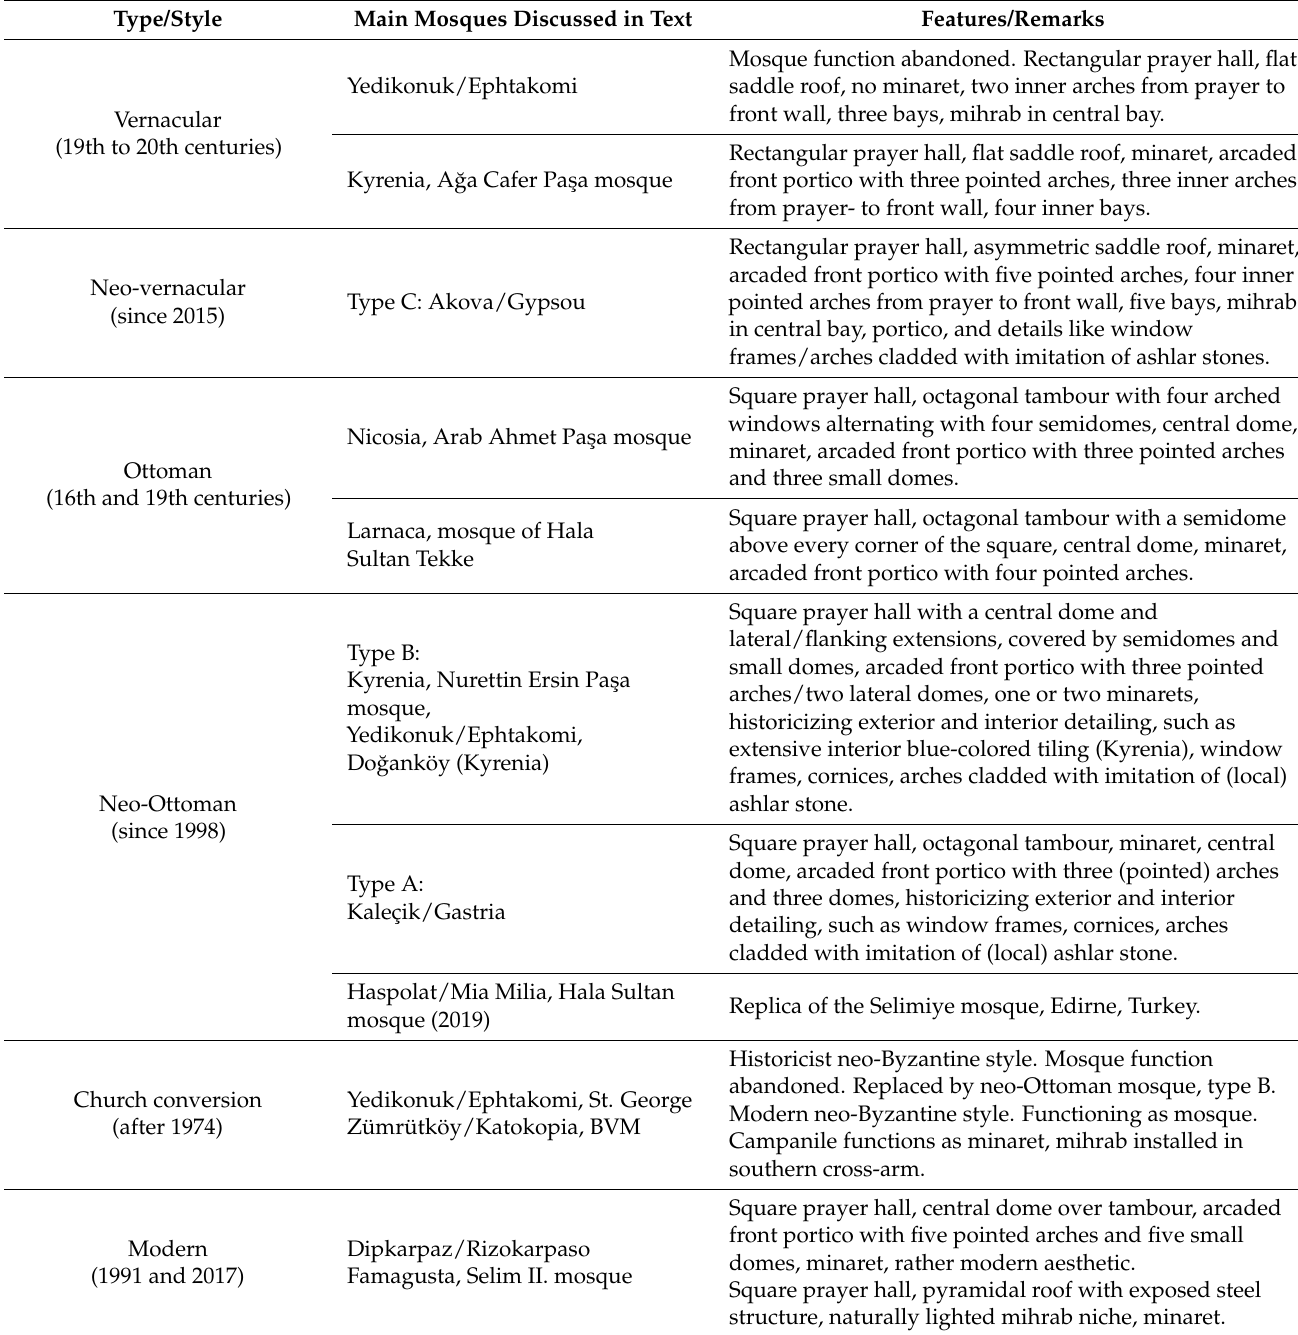
Table 1. Mosques in Cyprus, 19th to 20th